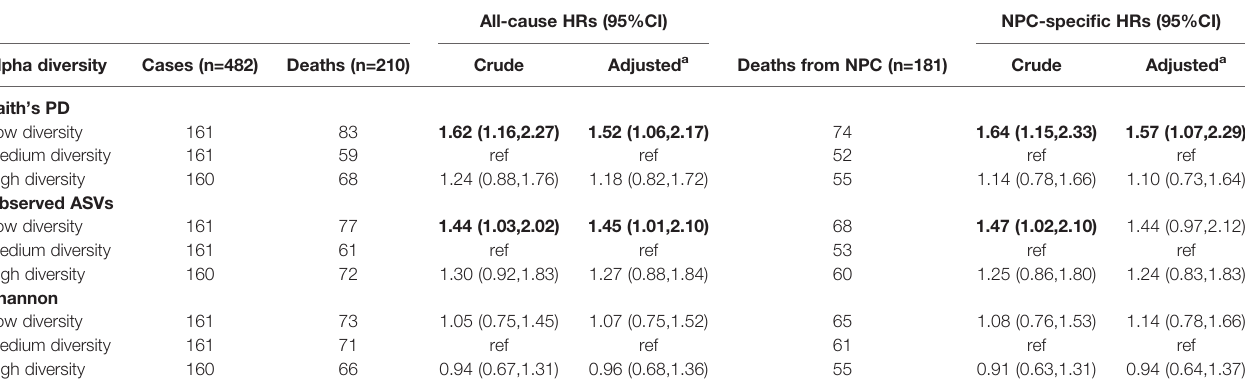
TABLE 2 | Hazard ratios (HRs) for mortality of NPC cases in relation to alpha diversity, Cox regression models. All-cause HRs